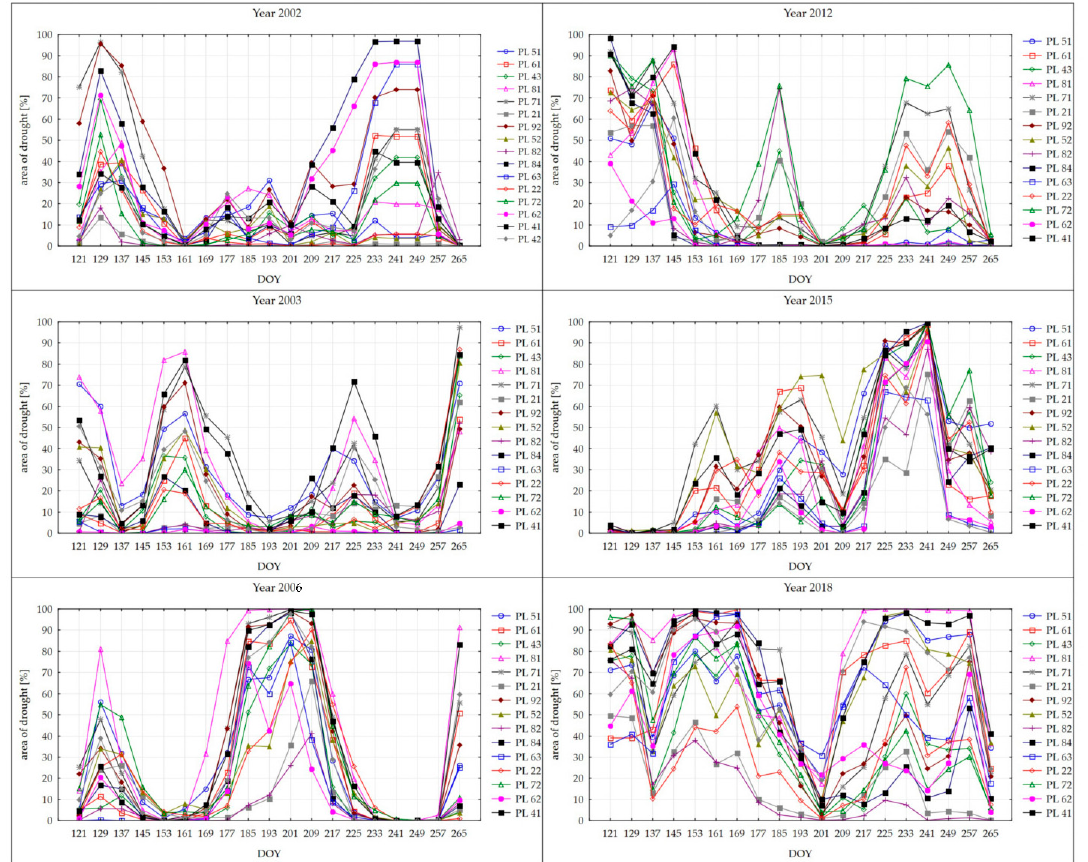
Figure 18. Percentage of drought area in Poland for the years 2002, 2003, 2006, 2012, 2015, and 2018.